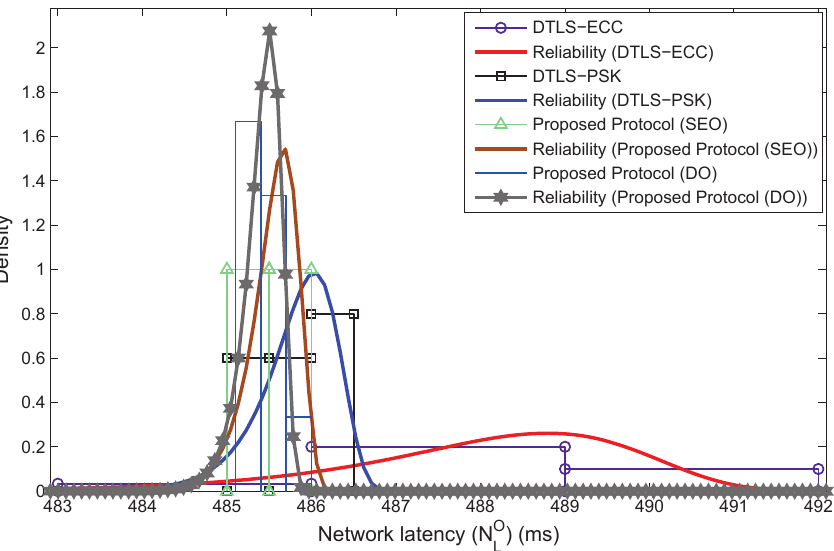
Figure 17. Density (network latency) vs. network latency with reliability